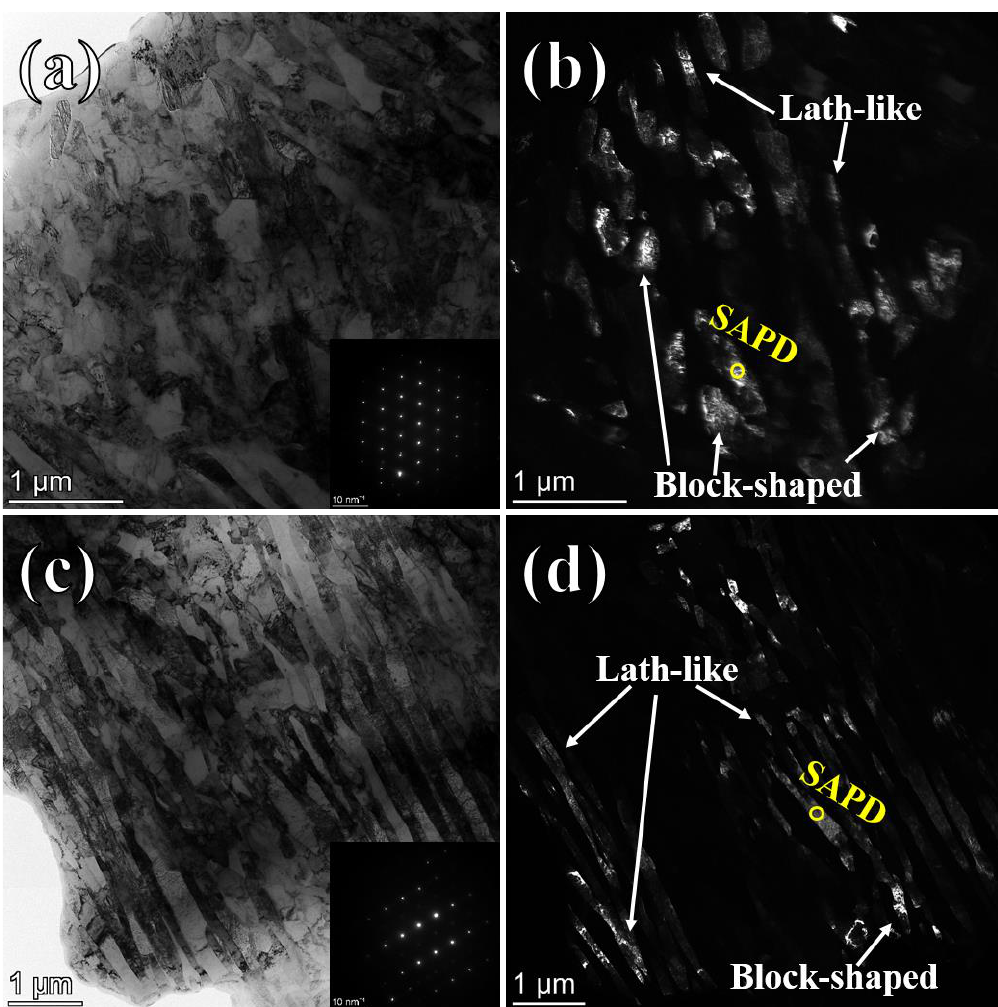
Figure 8. TEM of P300 and P260 samples: ( a ) bright-field image of P300 sample; ( b ) dark-field image of P300 sample; ( c ) bright-field image of P260 sample; ( d ) dark-field image of P260 sample.